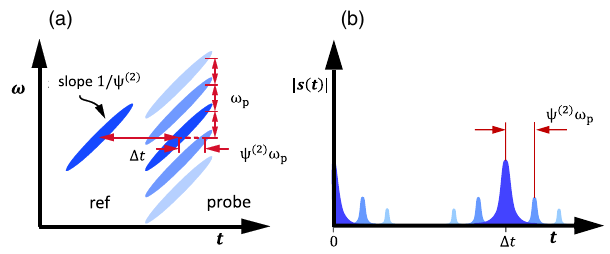
FIG. 1. (a) Frequency-time domain plots of the reference pulse, and the probe pulse after it has interacted with a sinusoidal plasma wave of frequency ω . Modulation of the probe pulse p 0 generates copies of the incident probe pulse, spectrally shifted by multiples of ω . (b) The TESS signal, obtained by a Fourier p 0 transform of the recorded spectrum of the transmitted probe and reference pulses. The temporal separation of the probe and reference pulses yields a DC term at t ¼ 0 and a sideband at t ¼ Δ t , and modulation of the probe causes a series of satellites (lighter blue) separated from the sideband by multiples ψ ð 2 Þ of ω p 0